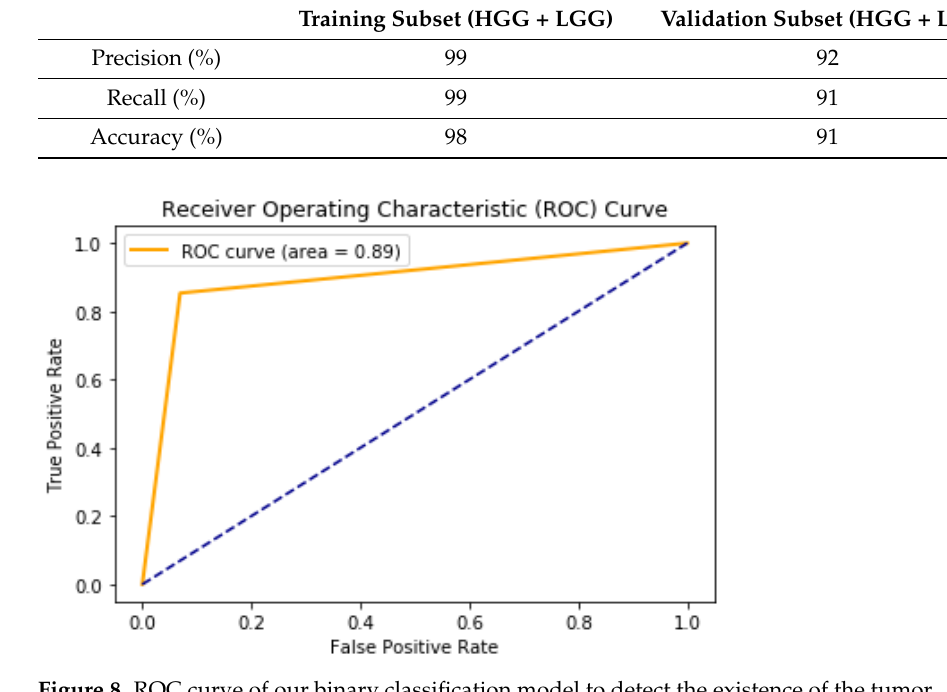
Figure 8. ROC curve of our binary classification model to detect the existence of the tumor.